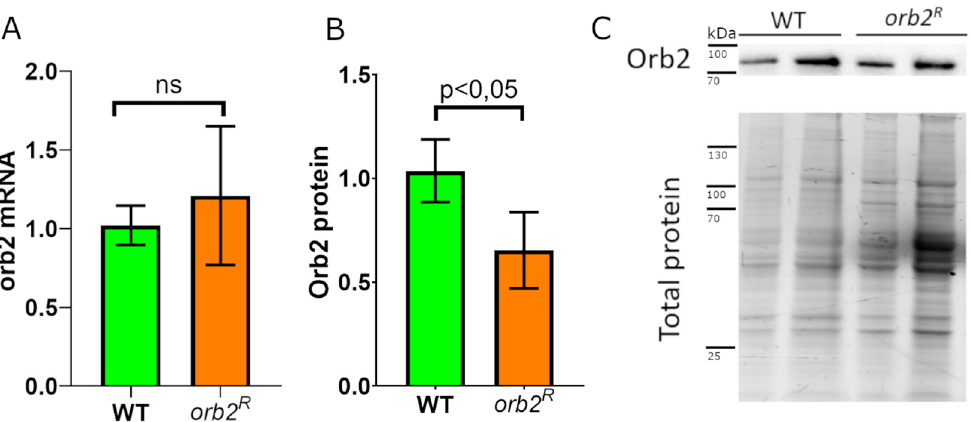
Figure 2. Effect of the 3 ′ UTR deletion on orb2 gene expression in the brain. ( A ) Relative levels of the orb2 mRNA in the heads of WT and orb2 R flies as determined by qPCR. ns - nonsignificant. ( B ) Relative amount of the Orb2 protein in the heads of WT and orb2 R flies as detected by semiquanti- tative Western blot. Error bars show the standard deviation ( t -test, n = 5). ( C ) Western blot analysis of head lysates of WT and orb2 R flies with antibodies against the Orb2 protein ( top ). Total protein staining ( below ) was used for normalization in two-fold serial dilution.